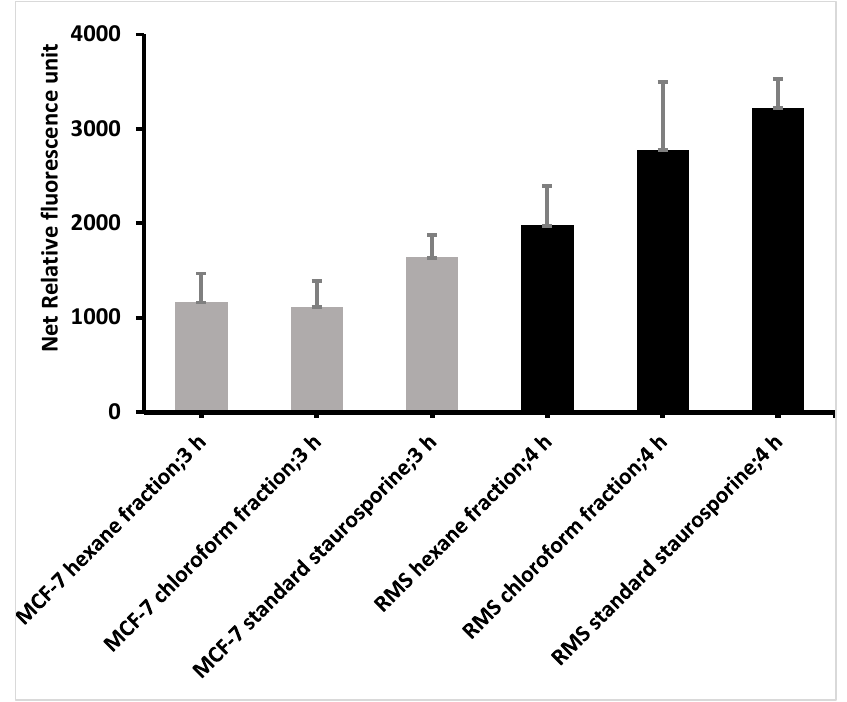
Figure 11. Caspase 3/7 activities of MCF-7 and RMS cells after the treatment with two different concentrations of hexane, chloroform fractions, and the standard staurosporine. In RMS cells, the highest caspase 3/7 activity was observed after 3 h of the caspase treatment, whereas in MCF-7 cells, the highest caspase activity was observed after 3 h of caspase treatment. Data are expressed as mean ± SD, based on triplicates.